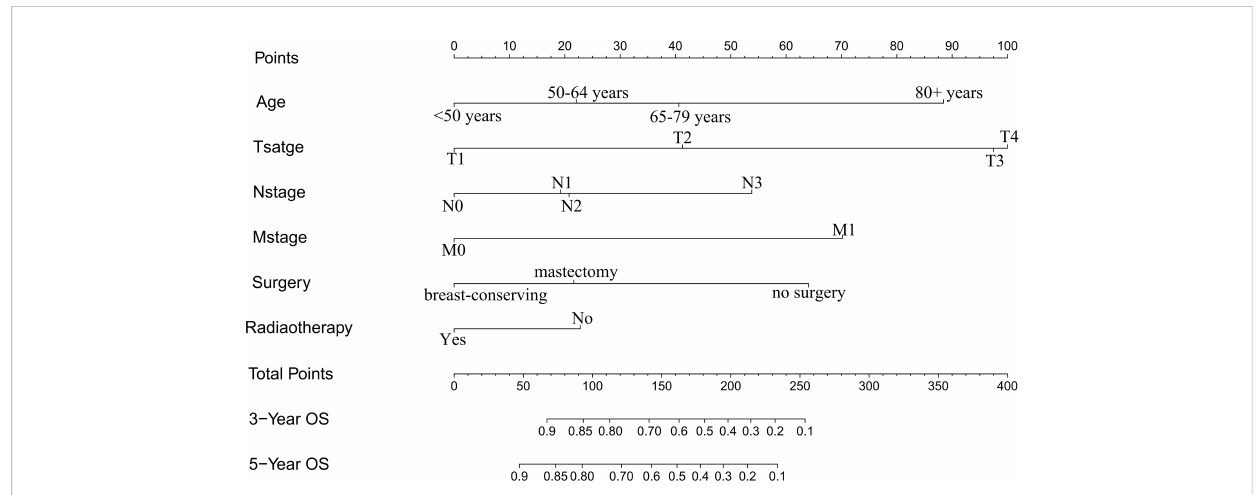
FIGURE 3 Nomogram predicted 3- and 5-year overall survival for patients with MBC. The nomogram is used by summing the points identi fi ed on the top scale for each independent covariate. The total points projected to the bottom scale indicated the % probability of the 3- and 5-year OS.